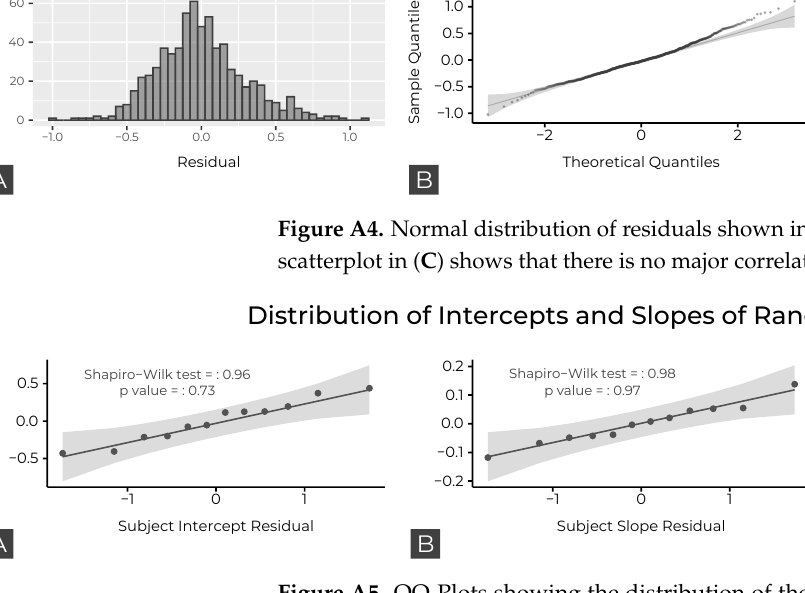
Figure A5. QQ-Plots showing the distribution of the residuals of random effects: ( A ) intercept of subjects, ( B ) slope of subjects (on TS), ( C ) intercept of layout.